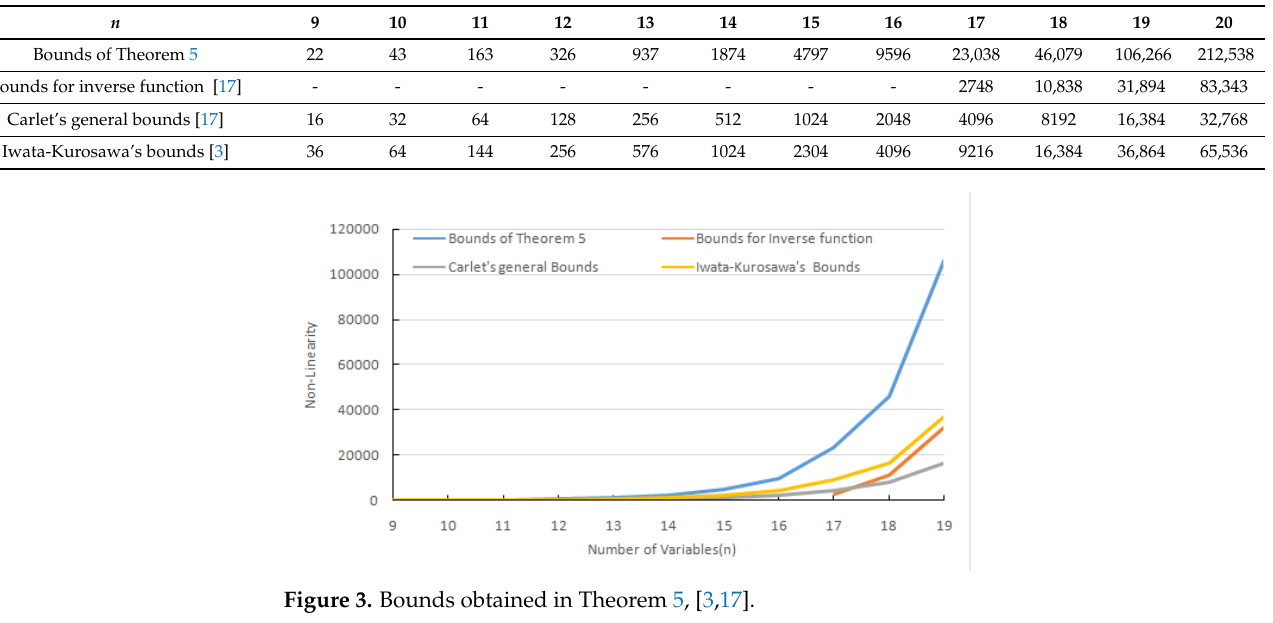
Table 3. Comparison of bounds due to Theorem 5, [3,17] for n ≥ 9.